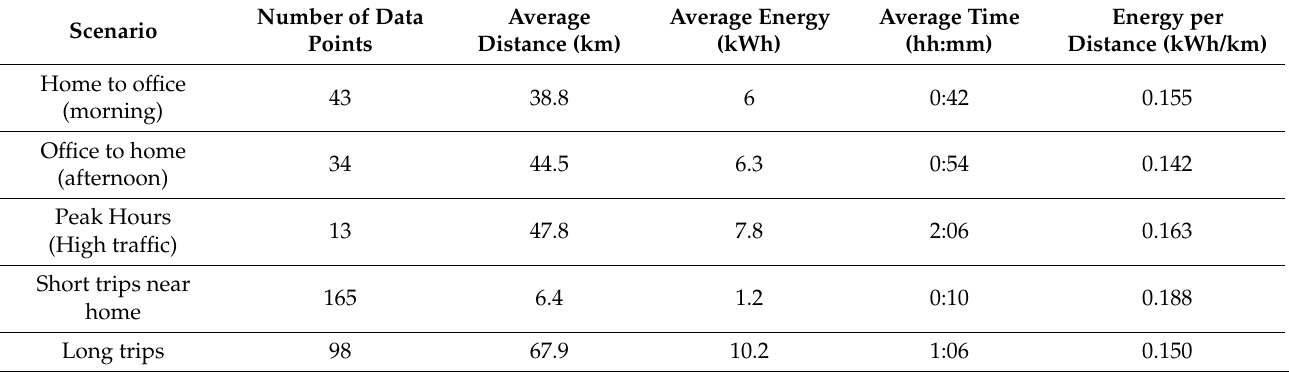
Table 6. Energy requirement under different